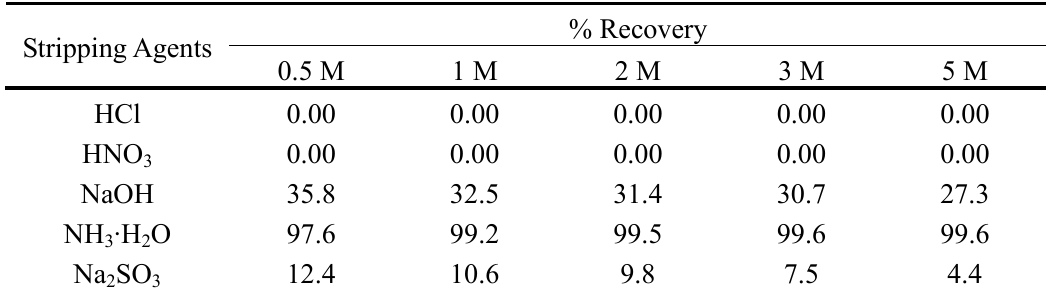
Figure 4 . Plot of Log D versus Log [ABSO]. [Pd(II)] = 100 mg·L -1 ; ■ : 0.1 M HCl; ▲ : 1.0 M HCl.